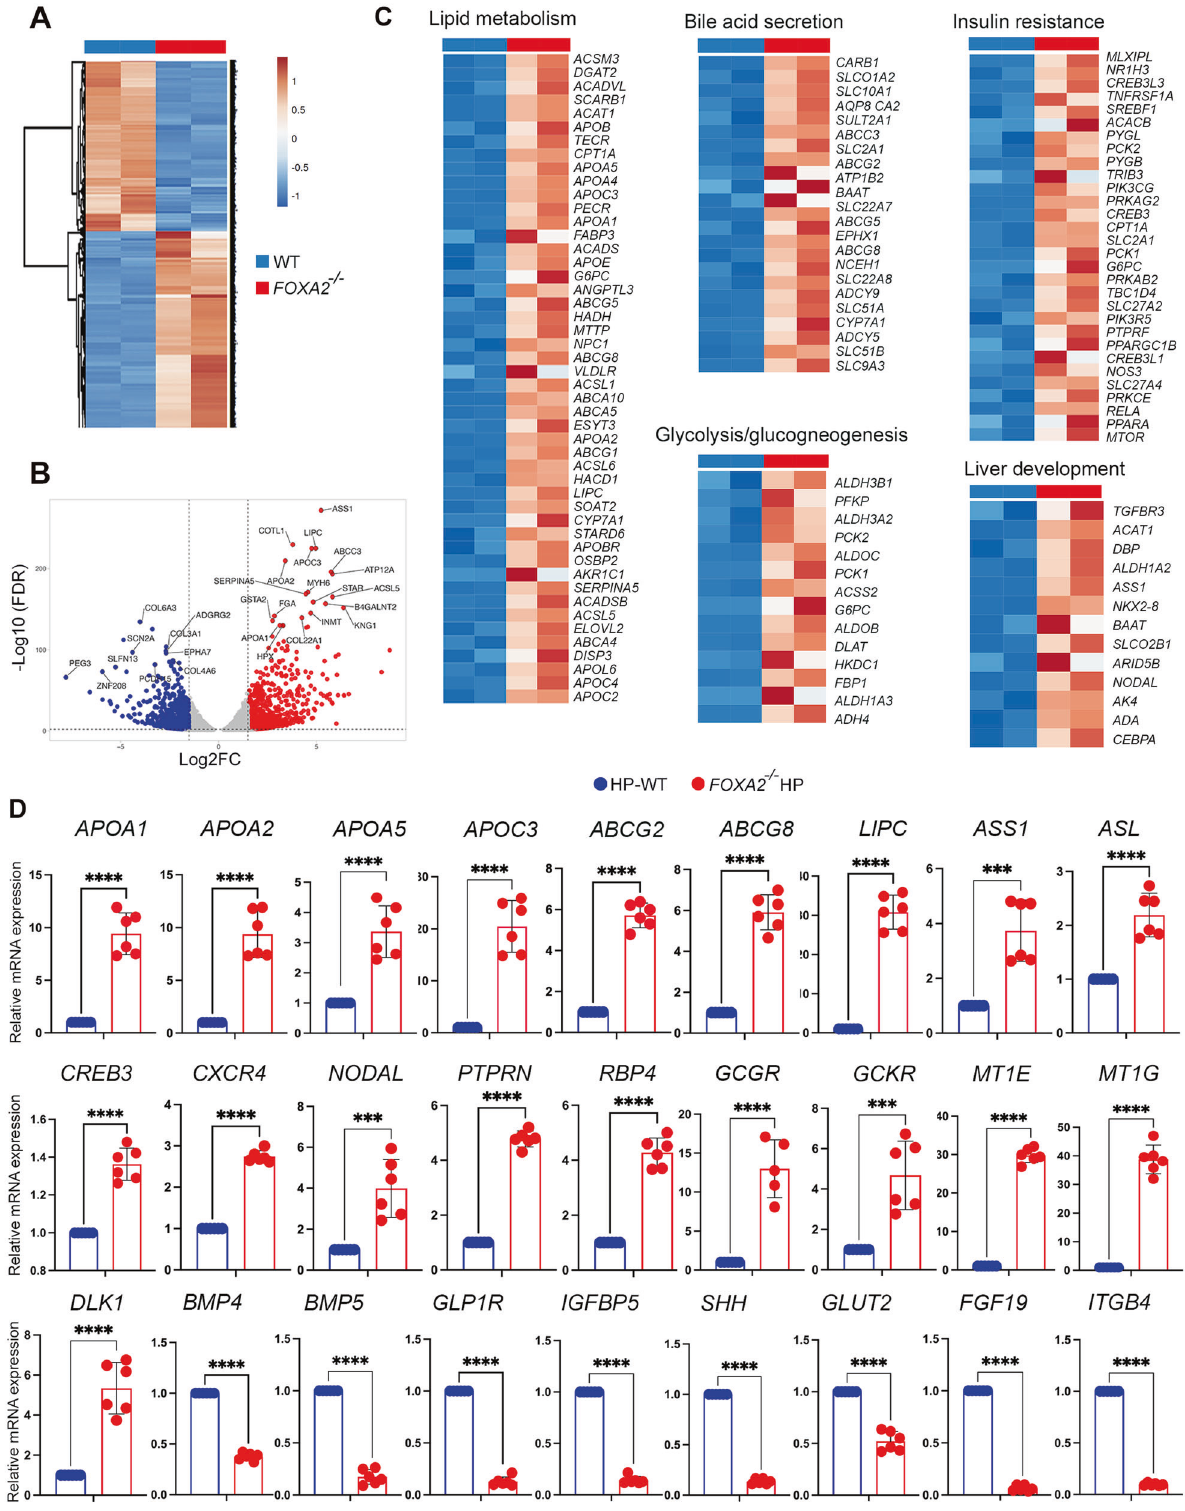
Fig. 5 RNA-seq analysis of hepatic progenitors derived from WT and FOXA2 − / − iPSCs. A A clustering heatmap of differentially expressed genes (DEGs) in hepatic progenitors (HP) derived from WT and FOXA2 − / − iPSCs. B Volcano plot of the differential gene expression between WT and FOXA2 − / − HP (FDR < 0.05). Blue dots indicate downregulated genes, while red dots represent upregulated genes in FOXA2 − / − HP. C Heatmaps of the key pathway-associated DEGs in FOXA2 − / − HP compared to WT-HP ( p -value < 0.05 and Log2 FC > 1.0). D Validation of RNA- seq results using RT-qPCR for the upregulated and downregulated genes ( n = 6). Data are represented as mean ± SD; * p < 0.05, ** p < 0.01, *** p < 0.001.